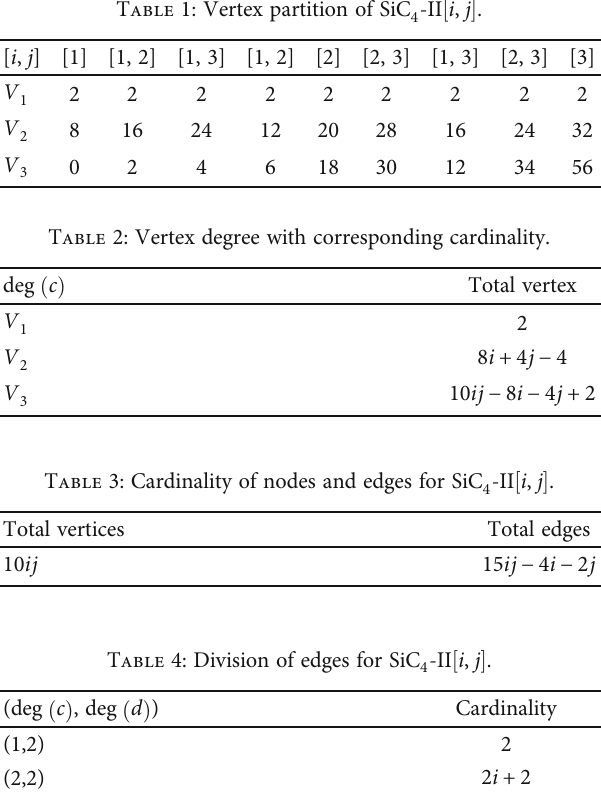
Table 6: Ve-degree of SiC